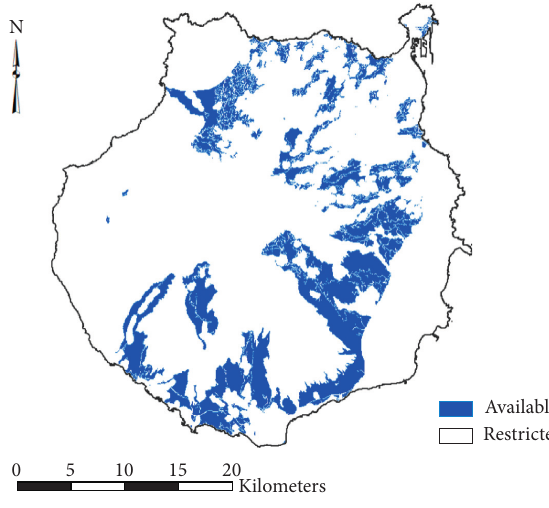
Figure 6: Wind constraint map.